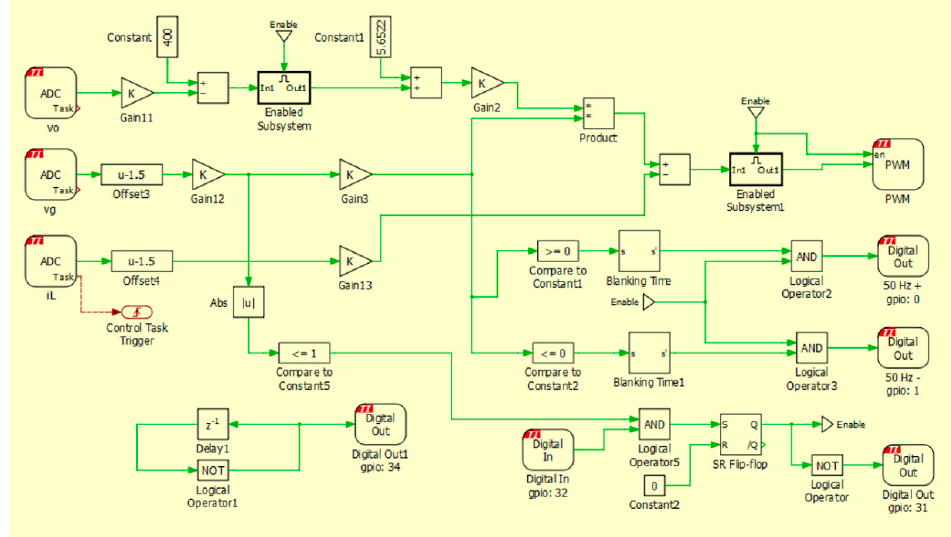
Figure 3. Rapid prototyping of the control using PLECS ® .